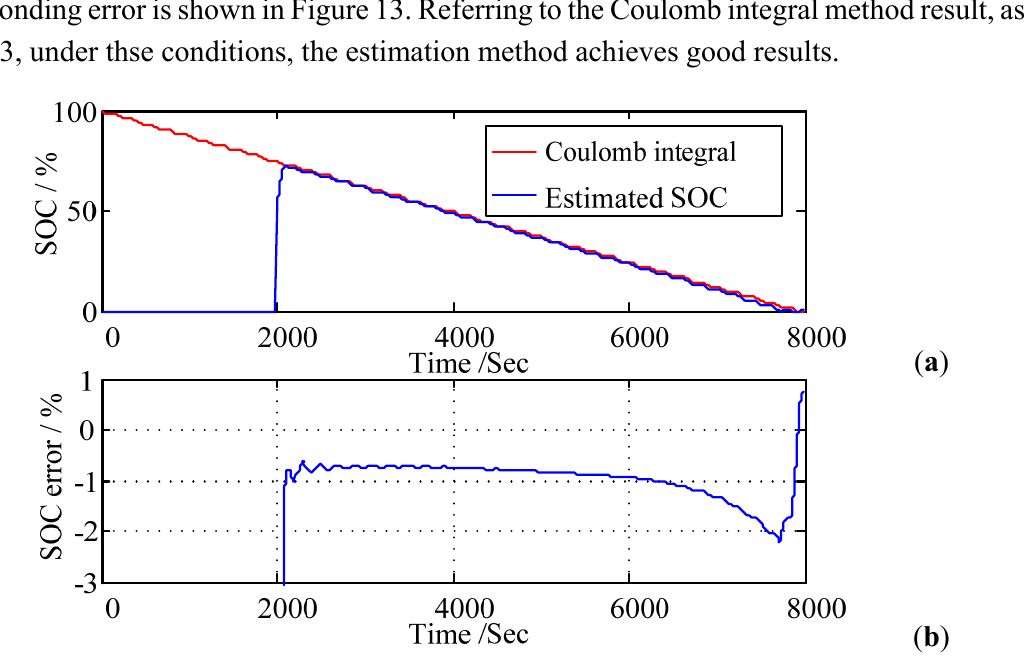
Figure 13. SOC estimation results and its error for a partly charged battery: ( a ) SOC estimation results; ( b ) SOC estimation